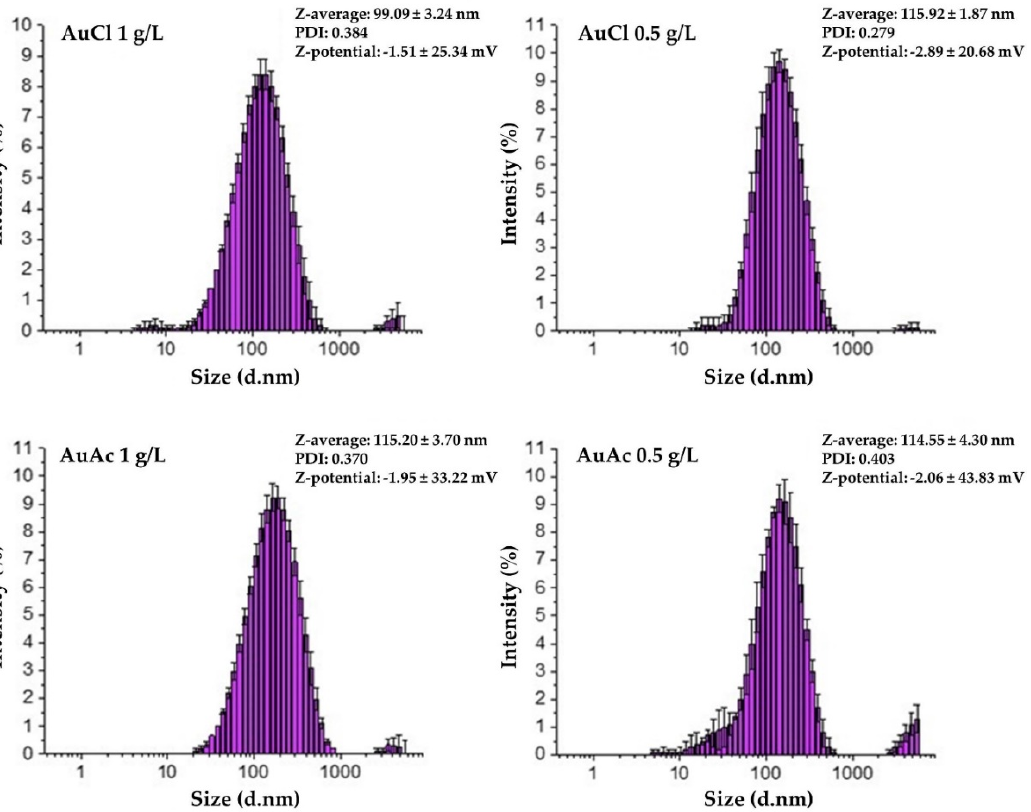
Figure 4. AuNPs’ size (hydrodynamic diameter) distribution by intensity, polydispersity index (PDI), and ζ -potential values for the as prepared gold inks.